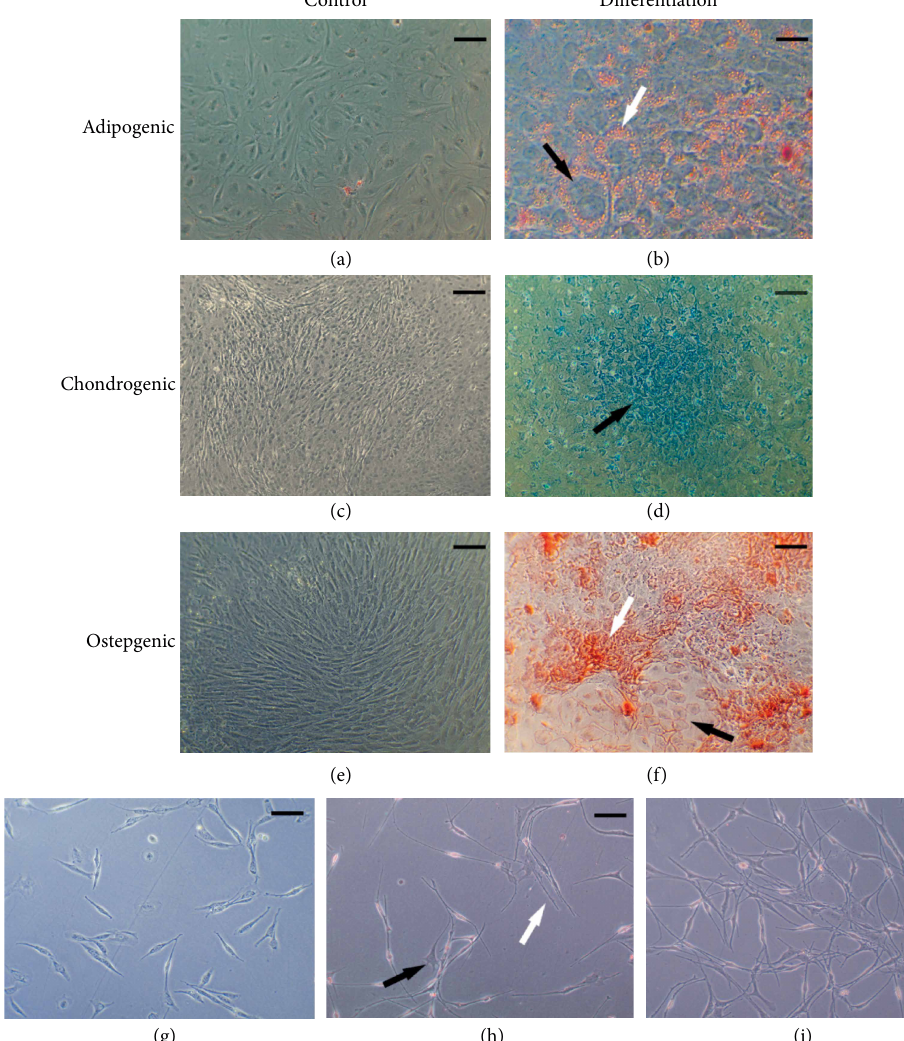
Figure 6: Cell differentiations. Magnification: 100x; Scale bar: 100 μ m. Adipogenic differentiation: (a) control; (b) presence of large round shaped cells (black arrow) and red stained lipid vacuoles inside the cytoplasm (white arrow); chondrogenic differentiation: (c) control; (d) presence of chondrogenic aggregate and extracellular matrix stained in blue (black arrow); osteogenic differentiation: (e) control; (f) presence of calcium containing osteocytes (black arrow) and extracellular calcium deposits (white arrow) stained in red; neurogenic differentiation: (g) control; (h) 24 h after addition of neurogenic induction medium, the cells acquired a neuroglial-like shape with development of dendrite (black arrow) and axonal-like (white arrow) cell structures (i) 72 h after addition of neurogenic induction